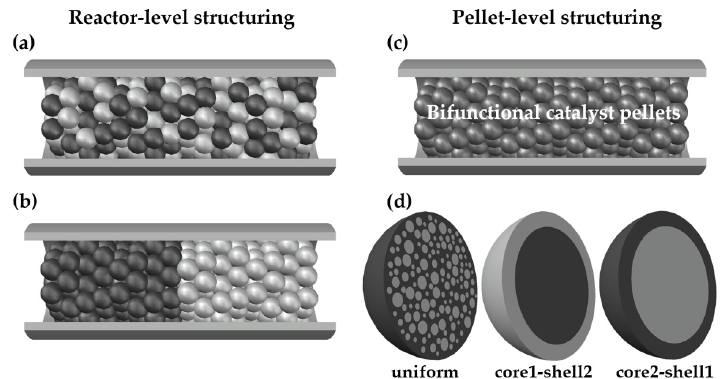
Figure 1. Structuring of catalytic activities at reactor level and at pellet level: ( a ) A physical mixture of monofunctional methanol (MeOH) and dimethyl ether (DME) catalyst pellets; ( b ) a layered distribution of monofunctional MeOH and DME catalyst pellets; ( c ) a fixed-bed made of bifunctional catalyst pellets; ( d ) bifunctional catalyst pellets with uniform, core1-shell2 and core2-shell1 distribution of two types of catalytic active sites.